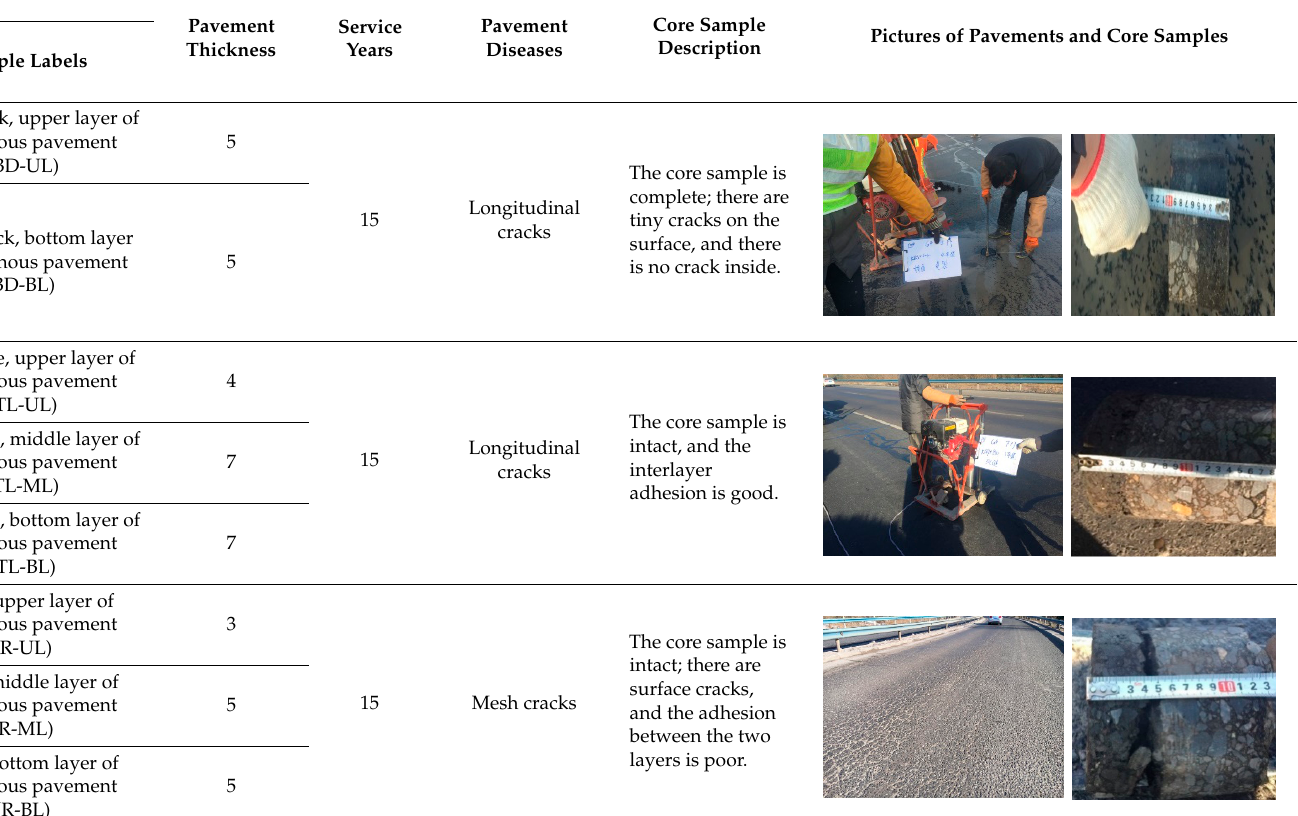
Table 1. Descriptions of different bituminous pavement structure and core samples.